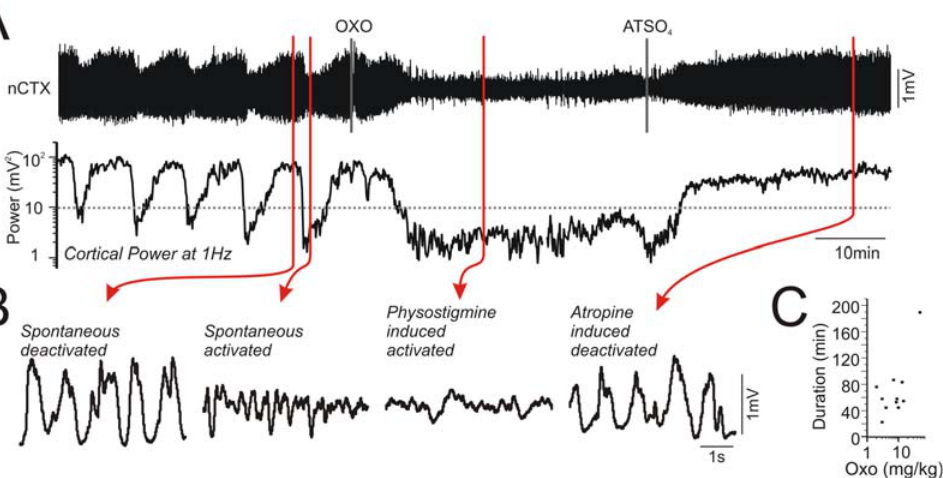
Figure 8. State alternations were dependent upon central muscarinic neurotransmission. A) Long duration cortical EEG traces in addition to spectrographic cortical power at 1 Hz demonstrating the effects of agonism and subsequent antagonism of muscarinic receptor mediated transmission. Following an i.p. injection of oxotremorine (4.0 mg/kg) spontaneous alternations between activated and deactivated states were abolished in favor of the activated state. This induced activated state was abolished in favor of the deactivated state with a subsequent i.p. injection of atropine sulfate (ATSO 4 : 50 mg/kg). B) Expansions of EEG traces from neocortical sites show the similarity of activated and deactivated patterns induced by cholinergic agonism and antagonism, respectively. C) A scatter plots demonstrating the duration of the oxotremorine effect as a function of dosage. The effects of oxotremorine were longer than those of physostigmine (Figure 6C). As in Figure 6, the effects of atropine showed no reversal.